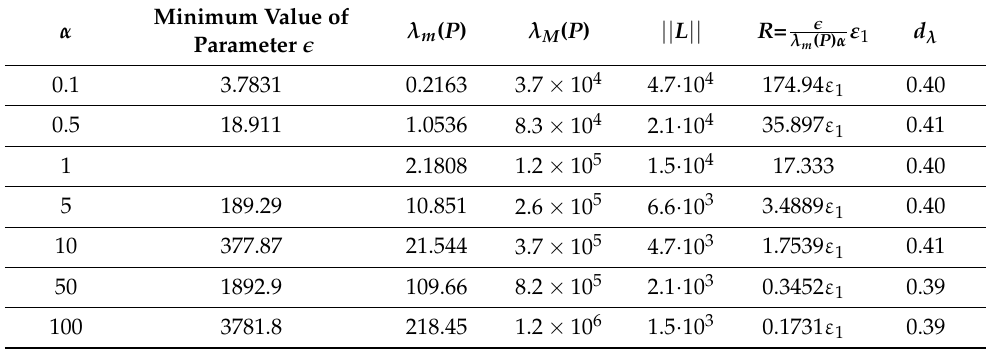
Table 2. Minimization of the (cid:101) subject to LMI (16) for various values of α .